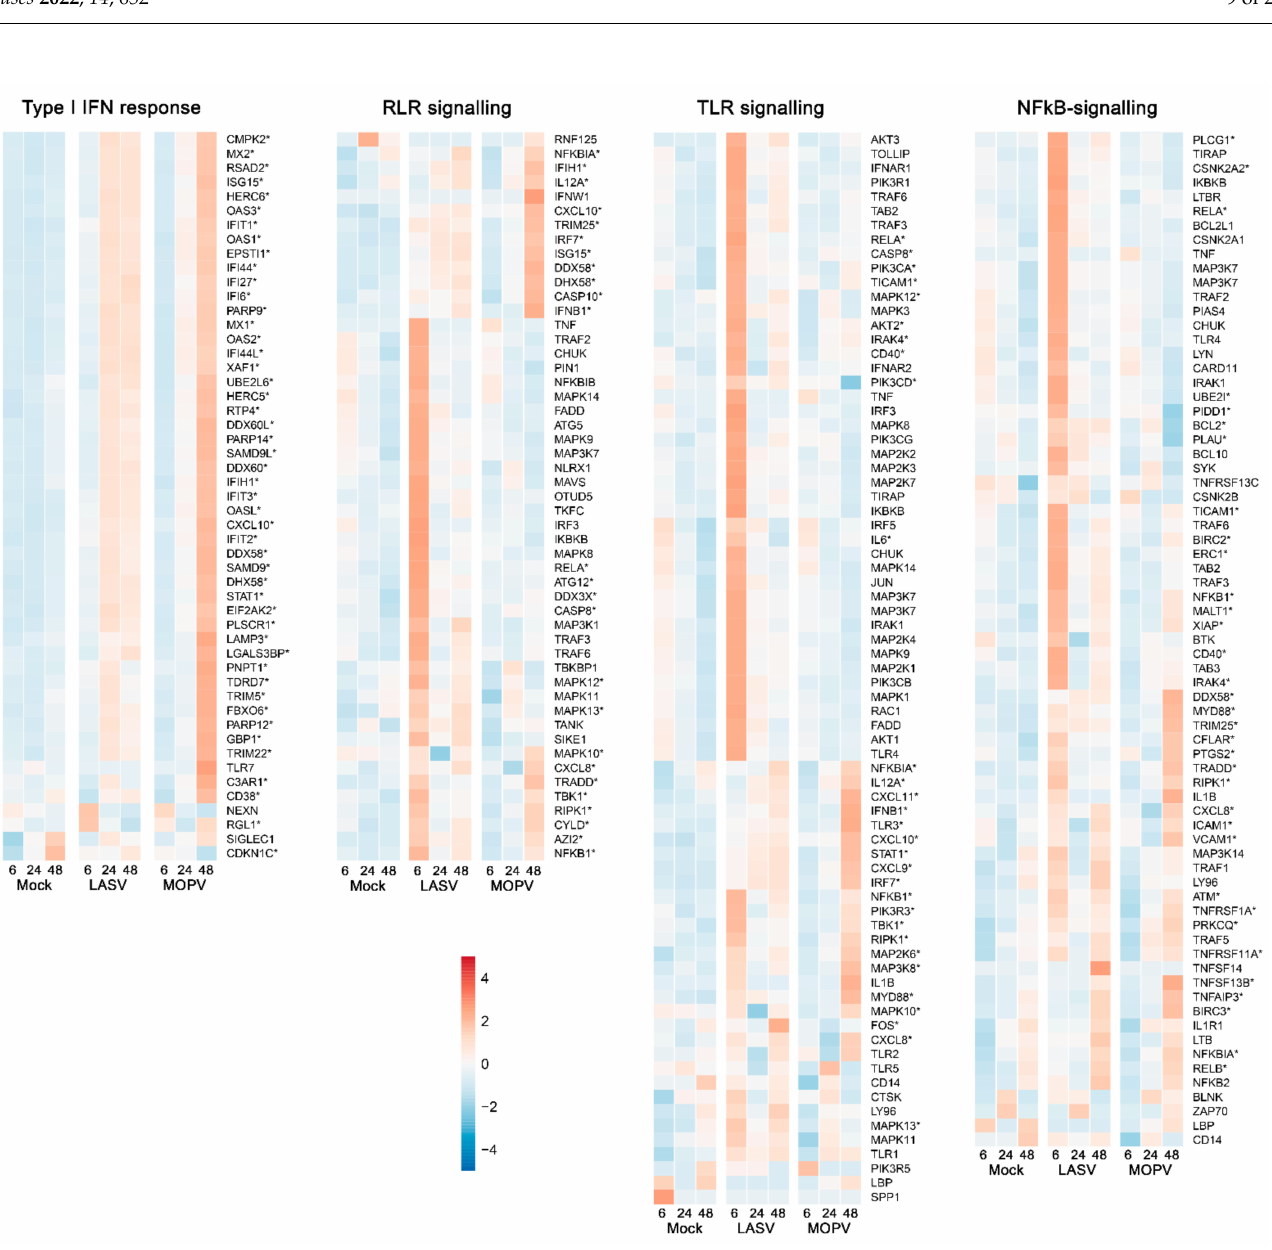
Figure 3. Heatmaps of the gene expression profiles of gene sets related to the type I IFN response and RLR, TLR, and NF κ B signaling. Genes that are DE in any of the pairwise comparisons are highlighted with asterisks. Gene expression was standardized by VST transformation, centered, and scaled to make the gene expression comparable, and hence averaged by condition and timepoint. p -values were adjusted for multiple-testing using the Benjamini–Hochberg